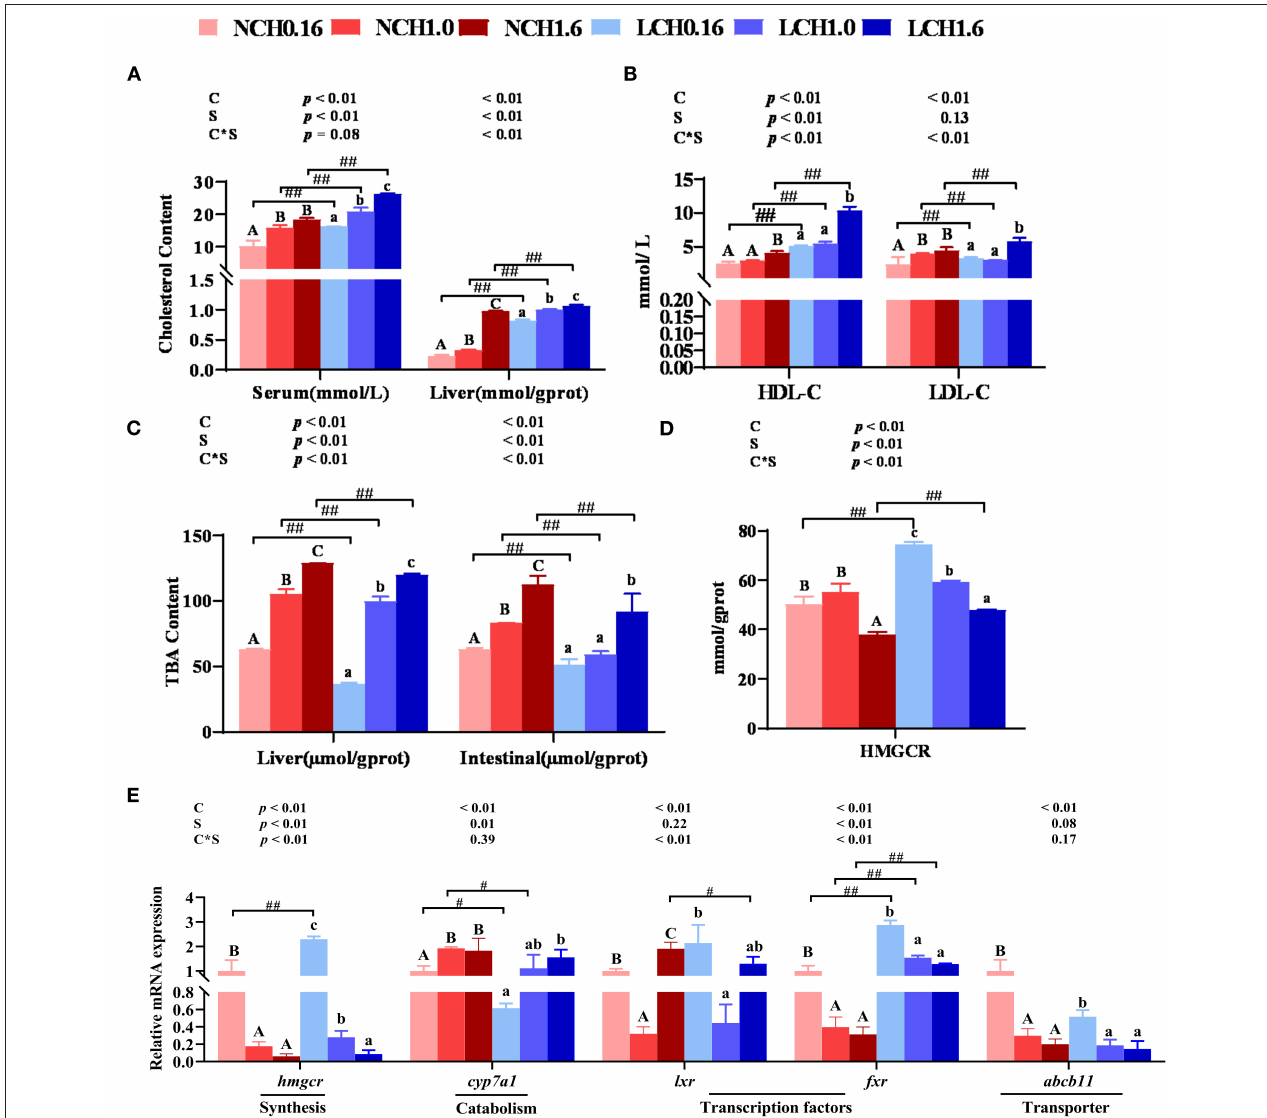
FIGURE 2 | . Effects of dietary cholesterol level and water salinity on cholesterol metabolism of juvenile black seabream ( Acanthopagrusschlegelii ). Contents of cholesterol in serum and liver (A) , content of total bile acid in serum and liver (B) , Hmgcr enzyme activities in liver (C) , concentrations of cholesterol transport in serum (D) , and relative genes expression involved in cholesterol metabolism in liver (E) . The group of NCH0.16 was set as the reference group, and the mRNA expression levels of target genes were normalized relative to the expression of β -actin. Values are presented as the means ( n = 3), with standard errors represented by vertical bars. Two-way ANOVA P -values are shown in each panel, with “C” representing effects of dietary cholesterol levels, “S” representing effects of salinity, and “C*S” representing the interaction between dietary cholesterol levels and salinity. “ABC” representing significant ( P < 0.05) difference between dietary cholesterol levels in normal water salinity (23 psu) and “abc” representing significant ( P < 0.05) difference between dietary cholesterol levels in low water salinity (5 psu) by performing one-way ANOVA. “#” representing significant ( P < 0.05) difference between water salinity with same dietary cholesterol level and “##” representing highly significant ( P < 0.01) difference between water salinity with same dietary cholesterol level by performing t- test. TBA, total bile acid; HDL-C, high-density lipoprotein cholesterol; LDL-C, low-density lipoprotein cholesterol; hmgcr, 3-Hydroxy-3-Methylglutaryl-CoA Reductase; cyp7a1, cholesterol 7 α -hydroxylase; lxr, liver x receptor; fxr, farnesoid X receptor; abcg5, ATP bind cassrtte transport g5; abcb11, ATP bind cassrtte transport b11.